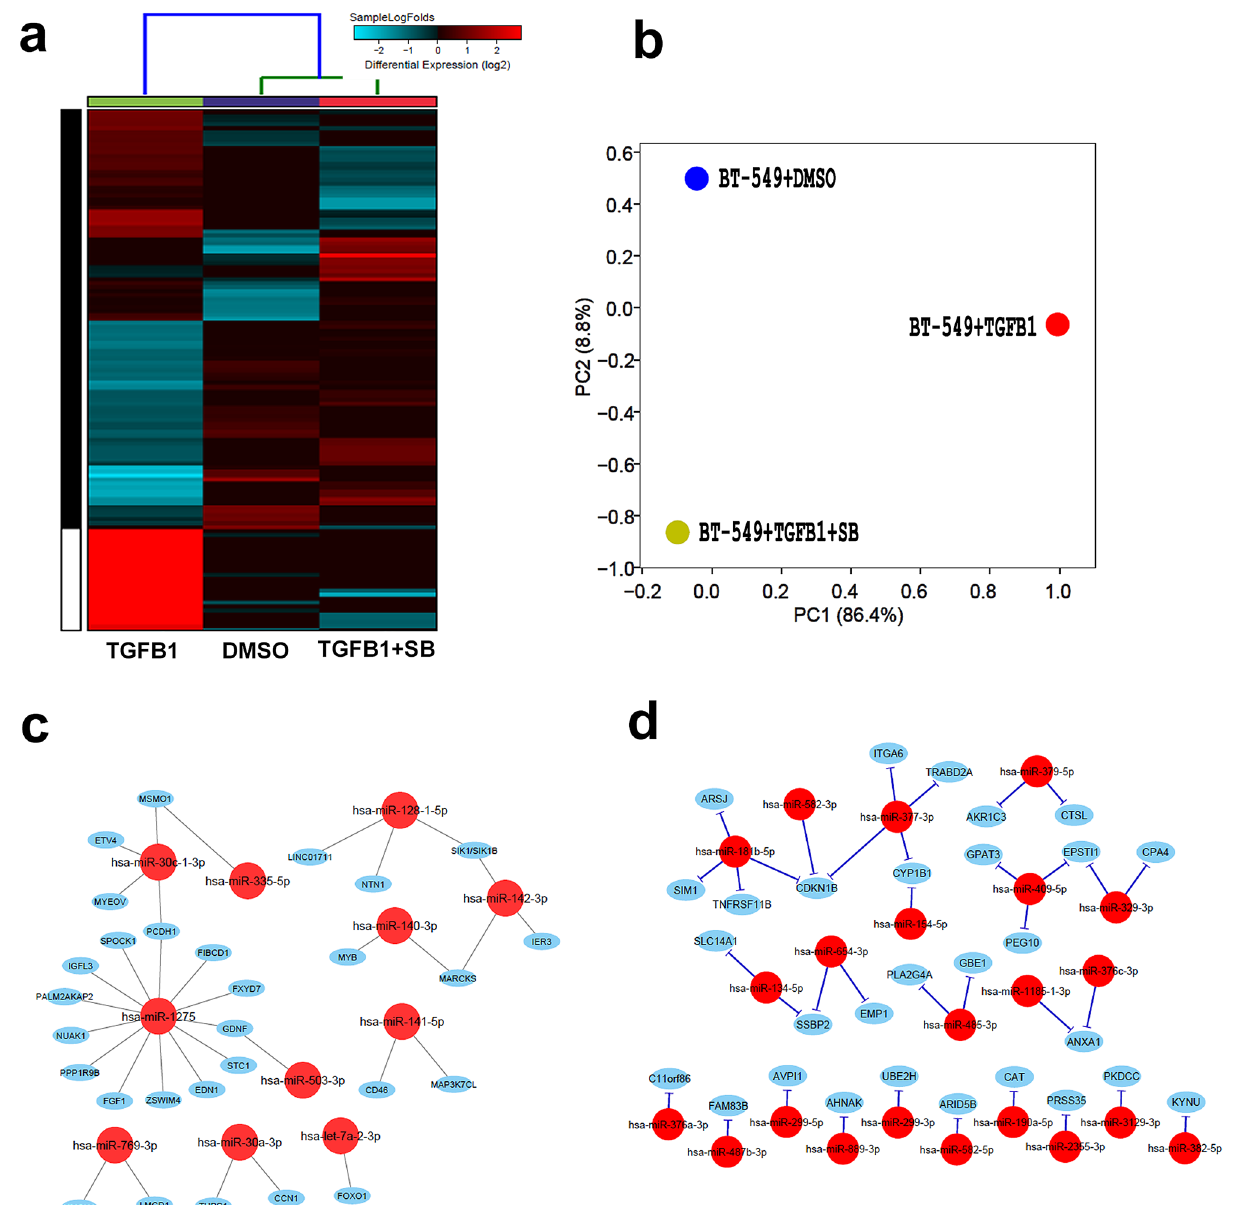
Figure 7. ( a ) Heatmap depicting changes in miRNA expression under different experimental conditions. ( b ) PCA analysis. ( c ) Highly predicted or validated mRNA targets of up (left) and down (right) based on Targetscan and IPA perdition that are affected in BT-549 under different experimental